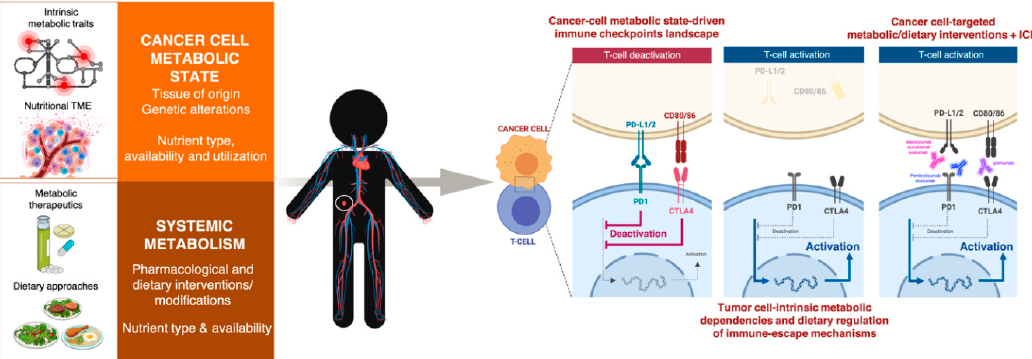
Figure 5. Metabolic state- and systemic metabolism-driven immune evasion landscape in cancer cells. Cancer cell metabolic states (which are determined by the tumor genetics, tissue of origin, and the cancer cell utilization of the available nutrients at the tumor microenvironment (TME)) and changes in the systemic metabolism of the host (which can be determined by the response to metabolic therapeutics and dietary interventions/modifications) can both alter cancer cell-intrinsic immune-evasion mechanisms, including the composition of the immune checkpoint landscape, and consequently dictate the responsiveness of tumor cells to immune checkpoint-based cancer immunotherapies.